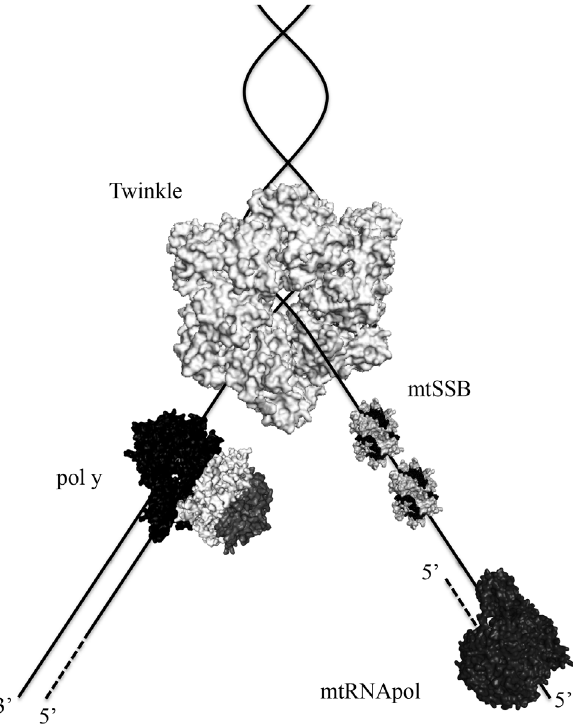
Figure 3 - Proteins at the human mtDNA replication fork. The schematic representationsoftheheterotrimericpol (cid:2) ,thehomotetramericmtSSBand themonomericmtRNApolwerecreatedbasedonthecrystalstructurefiles (accession numbers 3IKM, 3ULL and 3SPA, respectively) deposited in the RCSB Protein Data Bank. For Twinkle, the crystal structure of the homohexameric Bacillus stearothermophilus DnaB (4ESV) was used, al- though the oligomeric state of Twinkle appears to shift from a homohexameric to a homoheptameric conformation upon interactions with cofactors (Ziebarth et al. , 2010). For mtSSB, two tetramers are repre- sented wrapped around ssDNA. Technically, there is no experimental evi- dence showing that mtRNApol is part of the mtDNA replisome or that it movesalongwiththereplicationfork.Ourintentionhereistoillustratethe possible roles of mtRNApol as the mtDNA primase. The diagram is not to scale, nor is it meant to depict protein or DNA structure, or specific pro- tein-protein interactions. Solid lines represent DNA, and dashed lines rep- resent